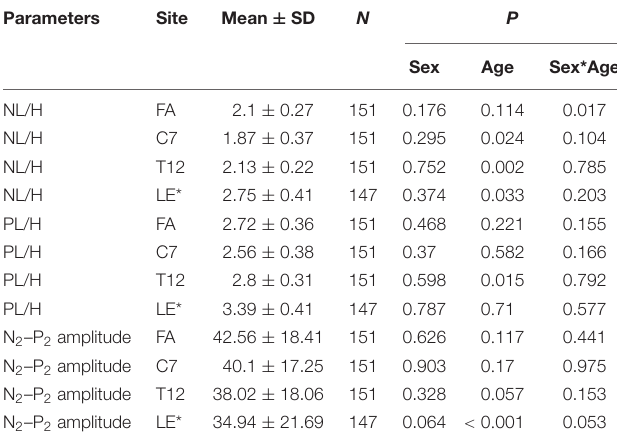
TABLE 3 | Influence of age, sex, and the interaction of sex*age on contact heat evoked potential parameters.